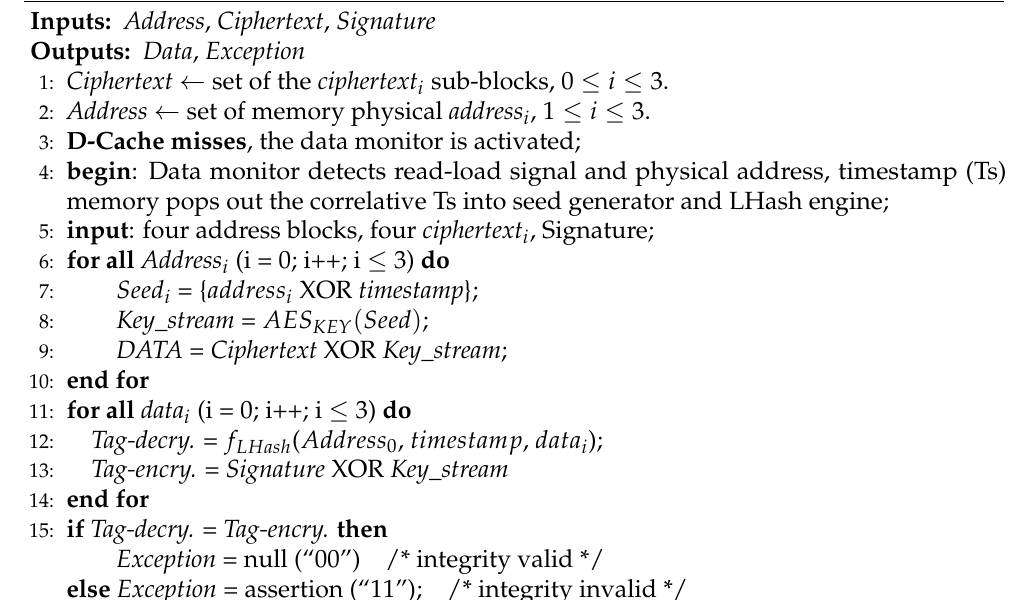
Algorithm 2 Data-load operation of 128-bit ciphertext block from external main